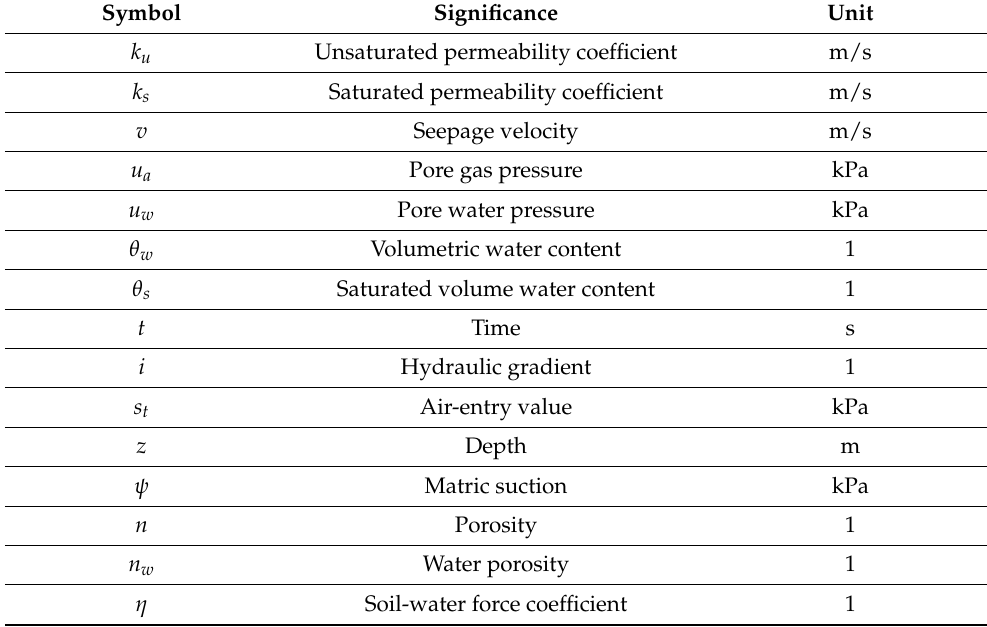
Table 1. List of main